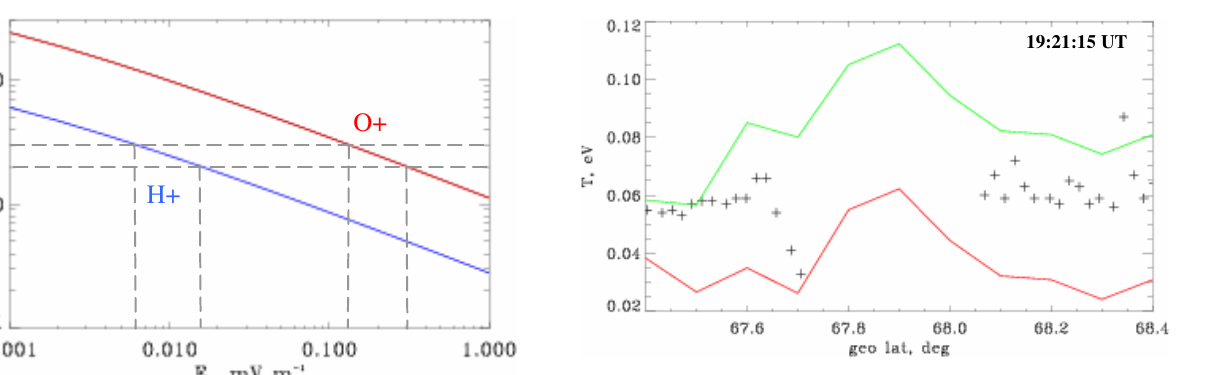
Fig. 13. Time flight of O + (red) and H + (blue) between 700 and 5000km in the field of Alfv´en wave versus amplitude of the field- aligned electric field at 5000km. Electric field is assumed to in- crease exponentially with altitude; characteristic height h is fixed at 450km and the upward velocity at 700km altitude is taken to be 1000ms − 1 .